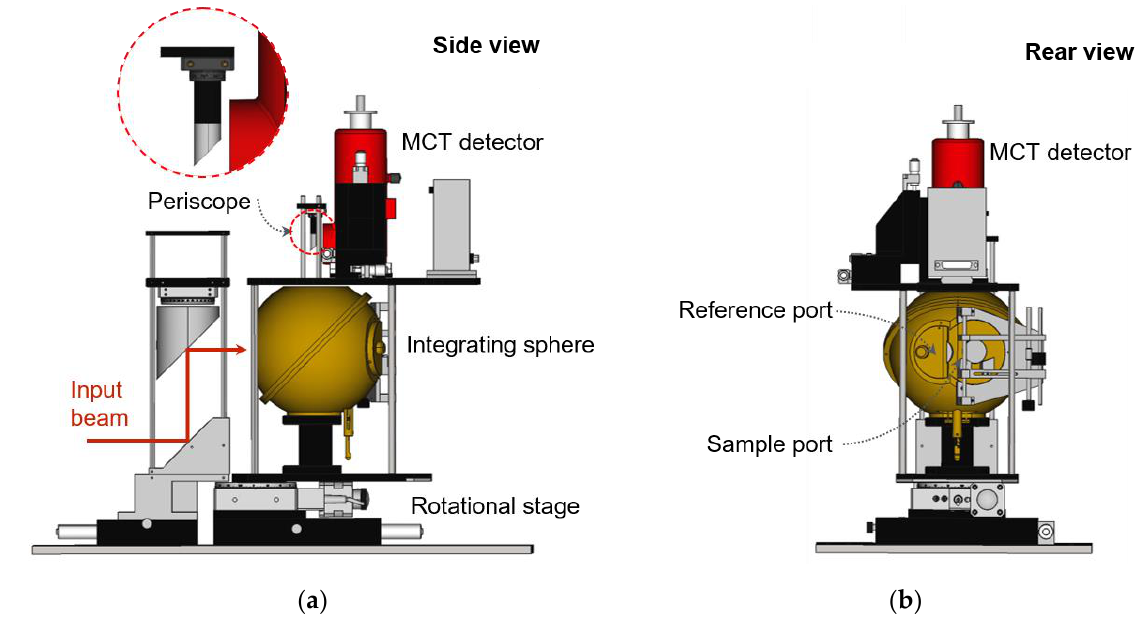
Figure 4. ( a ) Side view and ( b ) rear view schematic images of the relative reflectometer.